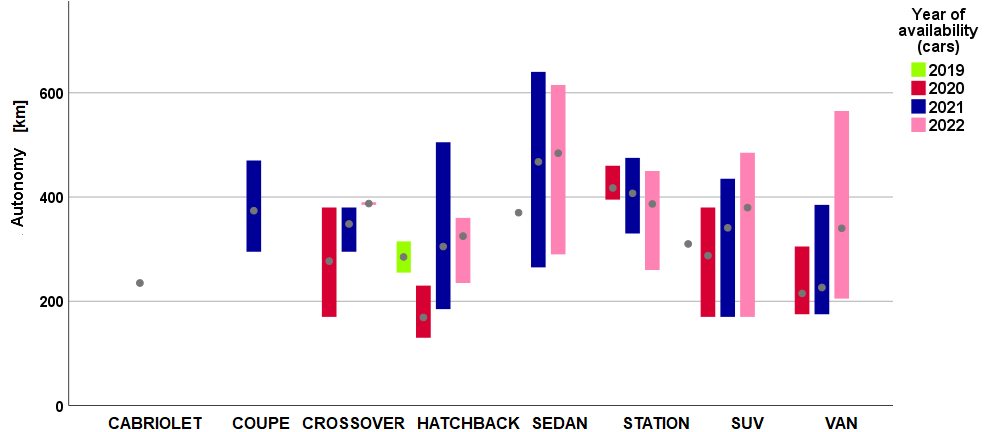
Figure 15. Range bar variation (min, max, mean) representation of autonomy vs. type of cars.